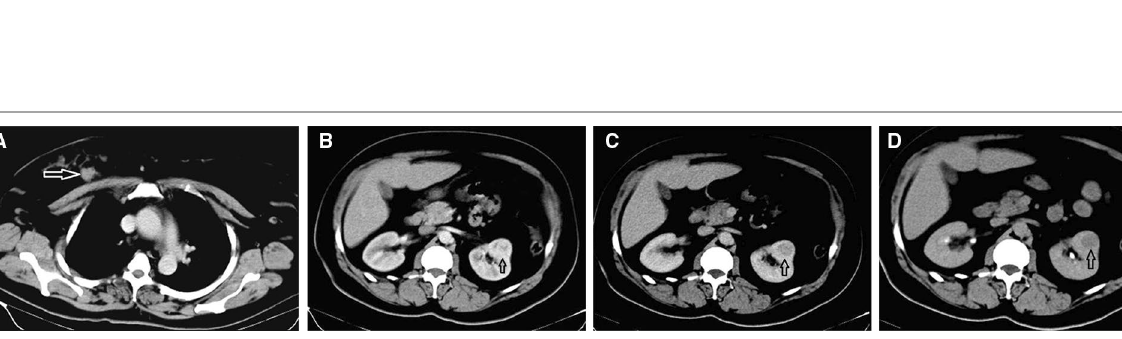
Fig. 2 45‑year‑old female presented with a right breast mass. a MDCT scan revealed right breast mass (arrow) with speculated inferior margin (Pathologically proved breast carcinoma). b-d arterial, portal and delayed phases revealed left renal mass (arrow) with a characteristic pattern of renal cell carcinoma (Pathologically proved RCC)